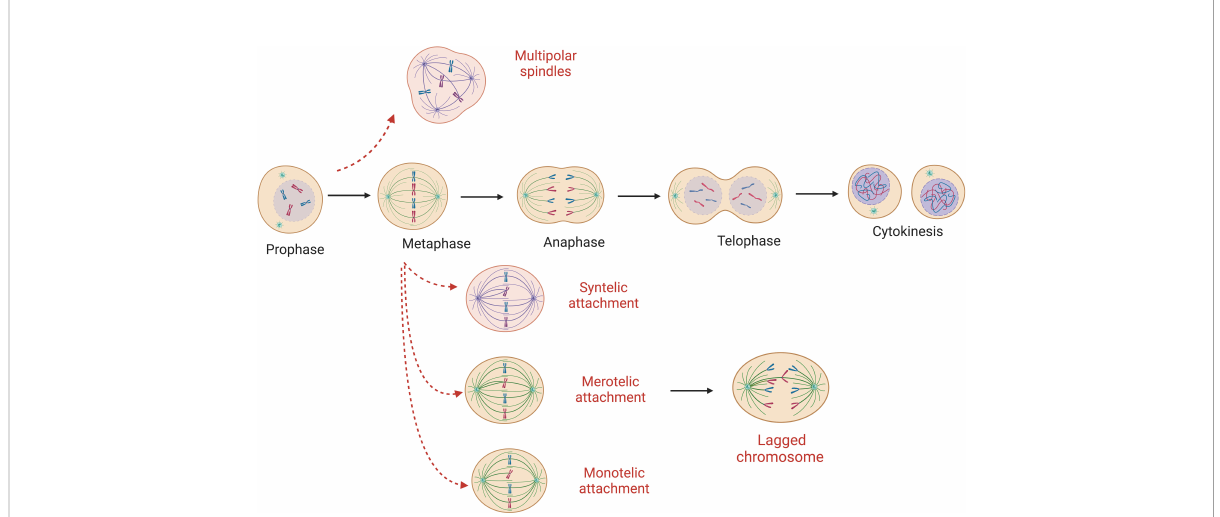
FIGURE 1 Abnormal microtubule attachments during mitosis. Red-dashed arrows show possible errors that can occur during cell replication ultimately leading to mis-segregated chromosomes. Here monotelic, syntelic, merotelic and multipolar spindle are represented. Absence of attachment and premature loss of sister chromatid cohesion are possible origins of W-CIN as